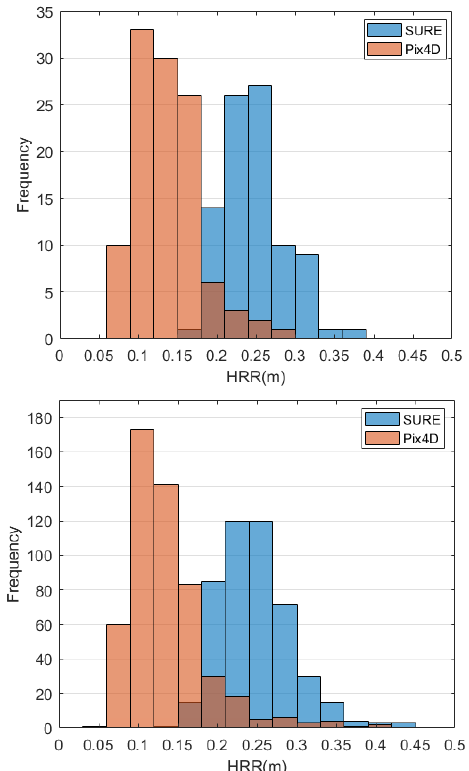
Figure 4. HRR Distribution for all the correctly filtered patches. Bin width is 3 cm. Top: paved ground; Bottom: grassland. The dark brown between the blue and light brown histograms is the overlap of the two histograms.